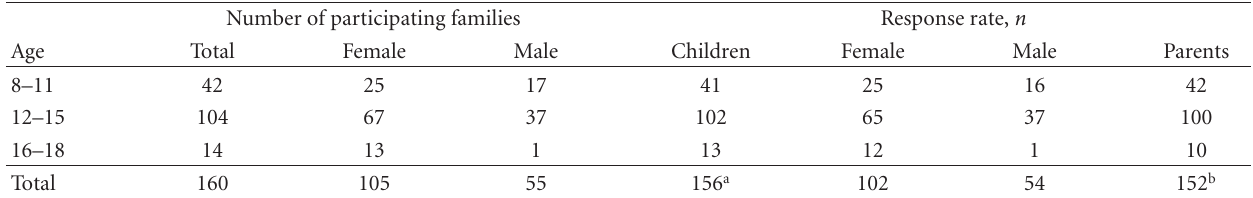
Table 1: Age and sex distribution of the study population and the response rate of the questionnaires. Number of participating families Response rate, n